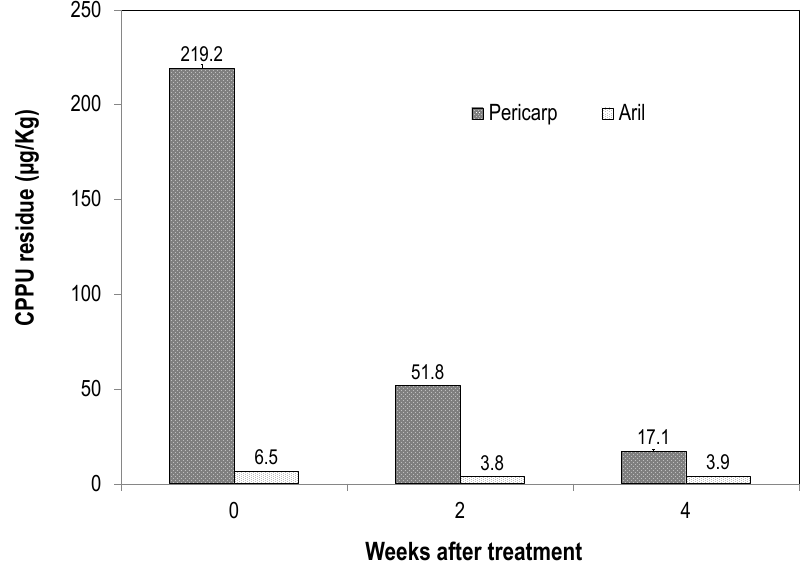
Figure 5. Dynamics of CPPU residue in the pericarp and the aril after 5 mg/L CPPU was applied to fruit 6 weeks after female bloom. Samples at 0 weeks after treatment were collected 2 h after treatment.